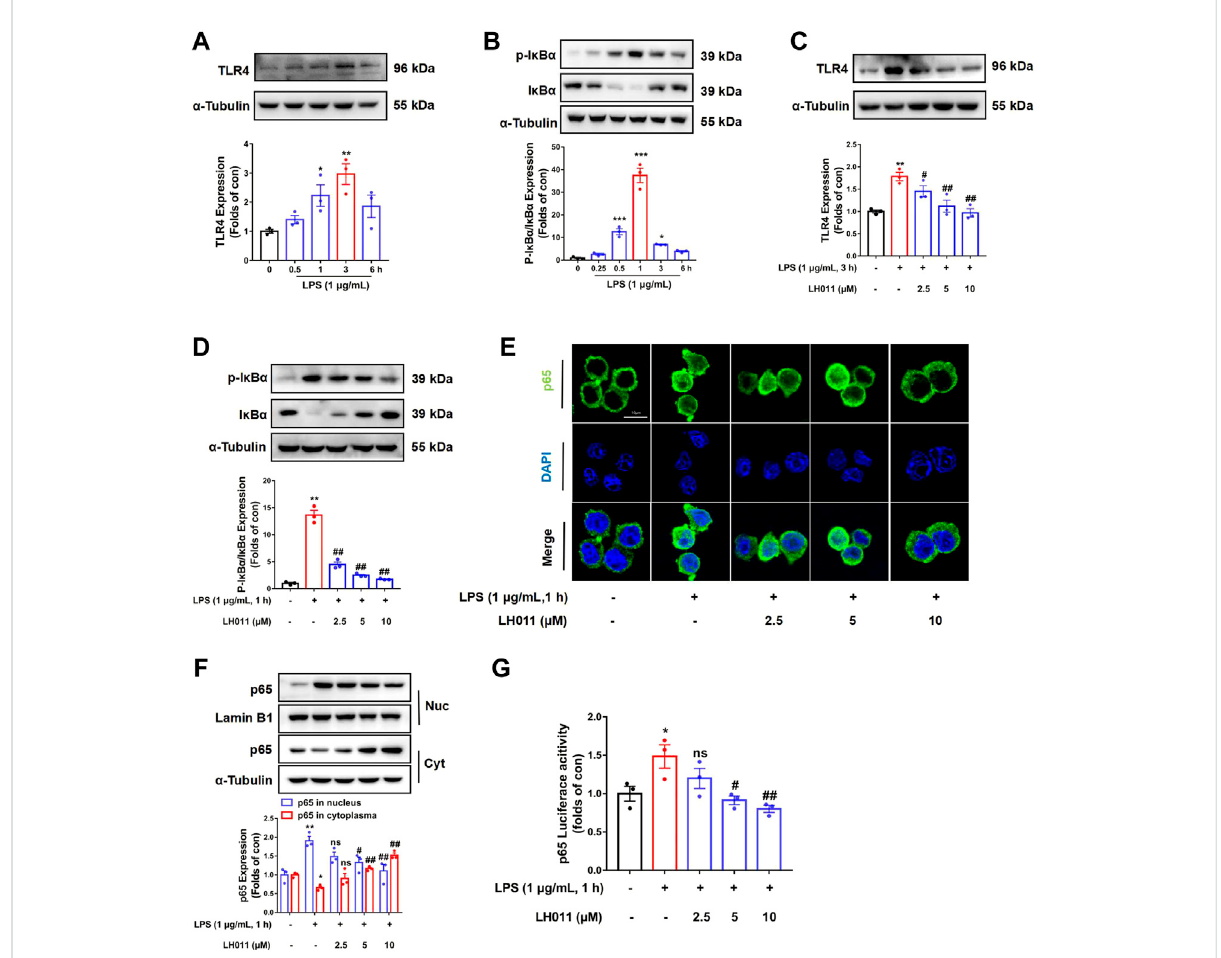
FIGURE 5 LH011 inhibited LPS-induced TLR4/NF- κ B signal activation in RAW 264.7 cells. LPS stimulated RAW 264.7 cells at different time points. (A,B) ProteinlevelsofTLR4,phosphorylatedI κ B α ,andtotalI κ B α weremeasuredbyWesternblot. (C) ProteinlevelofTLR4wasmeasuredinRAW264.7cells withLPSstimulateat3 h. (D) Proteinlevelofp-I κ B α andtotalI κ B α weremeasuredinRAW264.7cells,withLPSstimulateat1 hwithco-treatmentwith LH011. (E) Sub-localization of NF- κ B p65 was measured by immuno fl uorescence staining with LPS stimulate at 1 h with co-treatment with LH011, scale bar: 10 μ m. (F) Nucleic protein was extracted and the level of NF- κ B p65 was measured with LPS stimulate at 1 h with LH011 co- treatment. (G) Transcriptional activity of NF- κ B p65 was measured by dual-luciferase reporter assay with LPS stimulate at 1 h with LH011 co- treatment. All data are presented as the mean ± SEM (n = 3). * p < 0.05, ** p < 0.01, *** p < 0.001 vs. control group; # p < 0.05, ## p < 0.01 vs. LPS group; ns, no signi fi